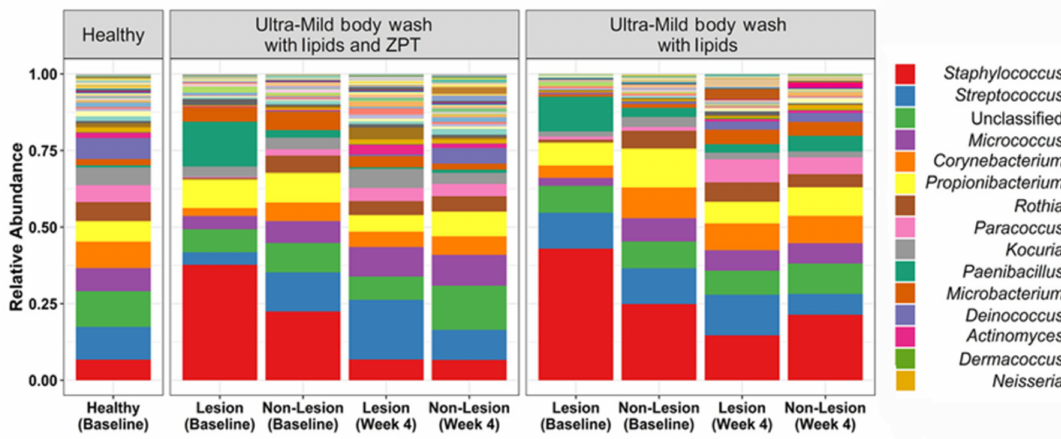
Figure 3. Bacterial relative abundance after treatment with lipidic body washes, with and without zinc pyrithione (ZPT), on lesional and non-lesional skin of young AD patients. The AD skin microbiome achieved a similar composition to the healthy controls after four weeks of body wash with lipids and ZPT treatment, and reduction in the relative abundance of S. aureus . Adapted from Reference